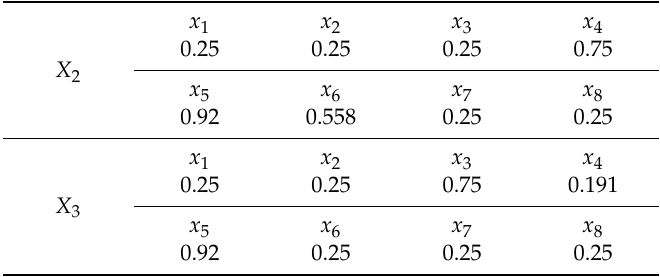
Table 27. Fuzzy reliability of each